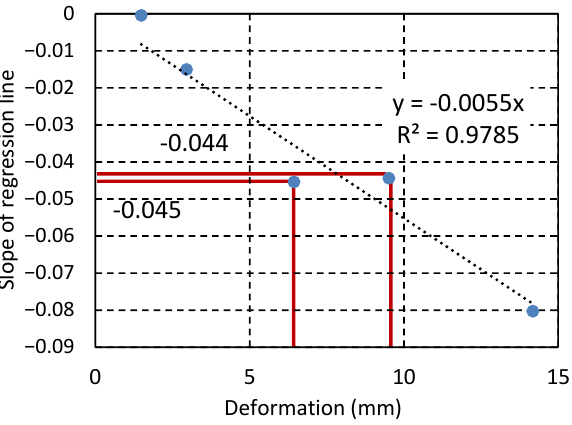
Figure 5. Relationship between deformation and slope of regression line (Plywood).